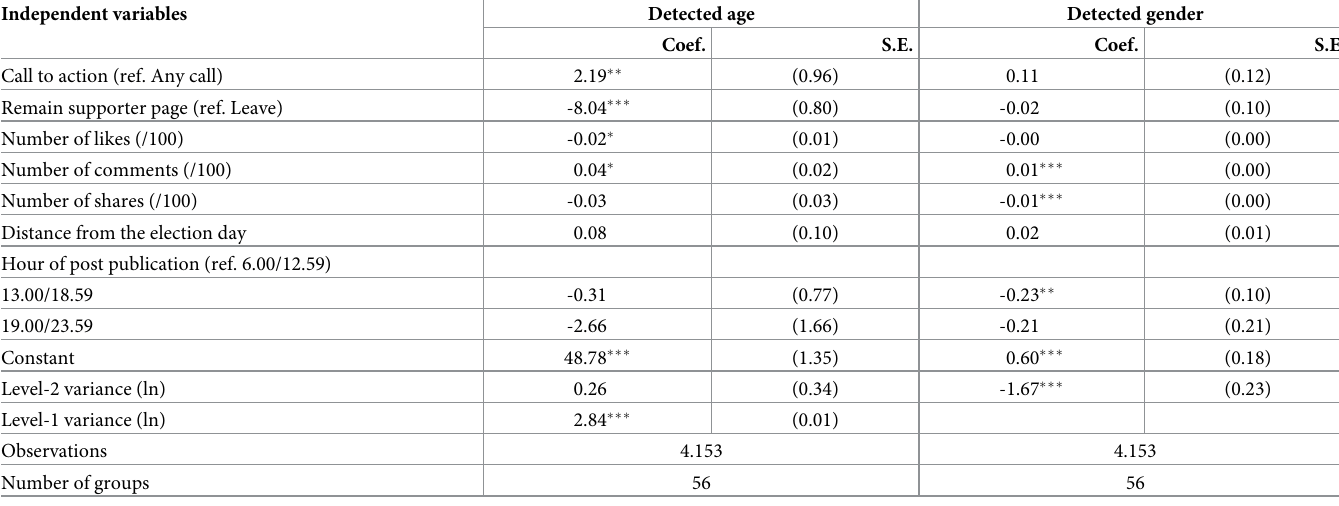
Table 2. Detected age, gender and nature of the message (call to action vs. any action). Independent